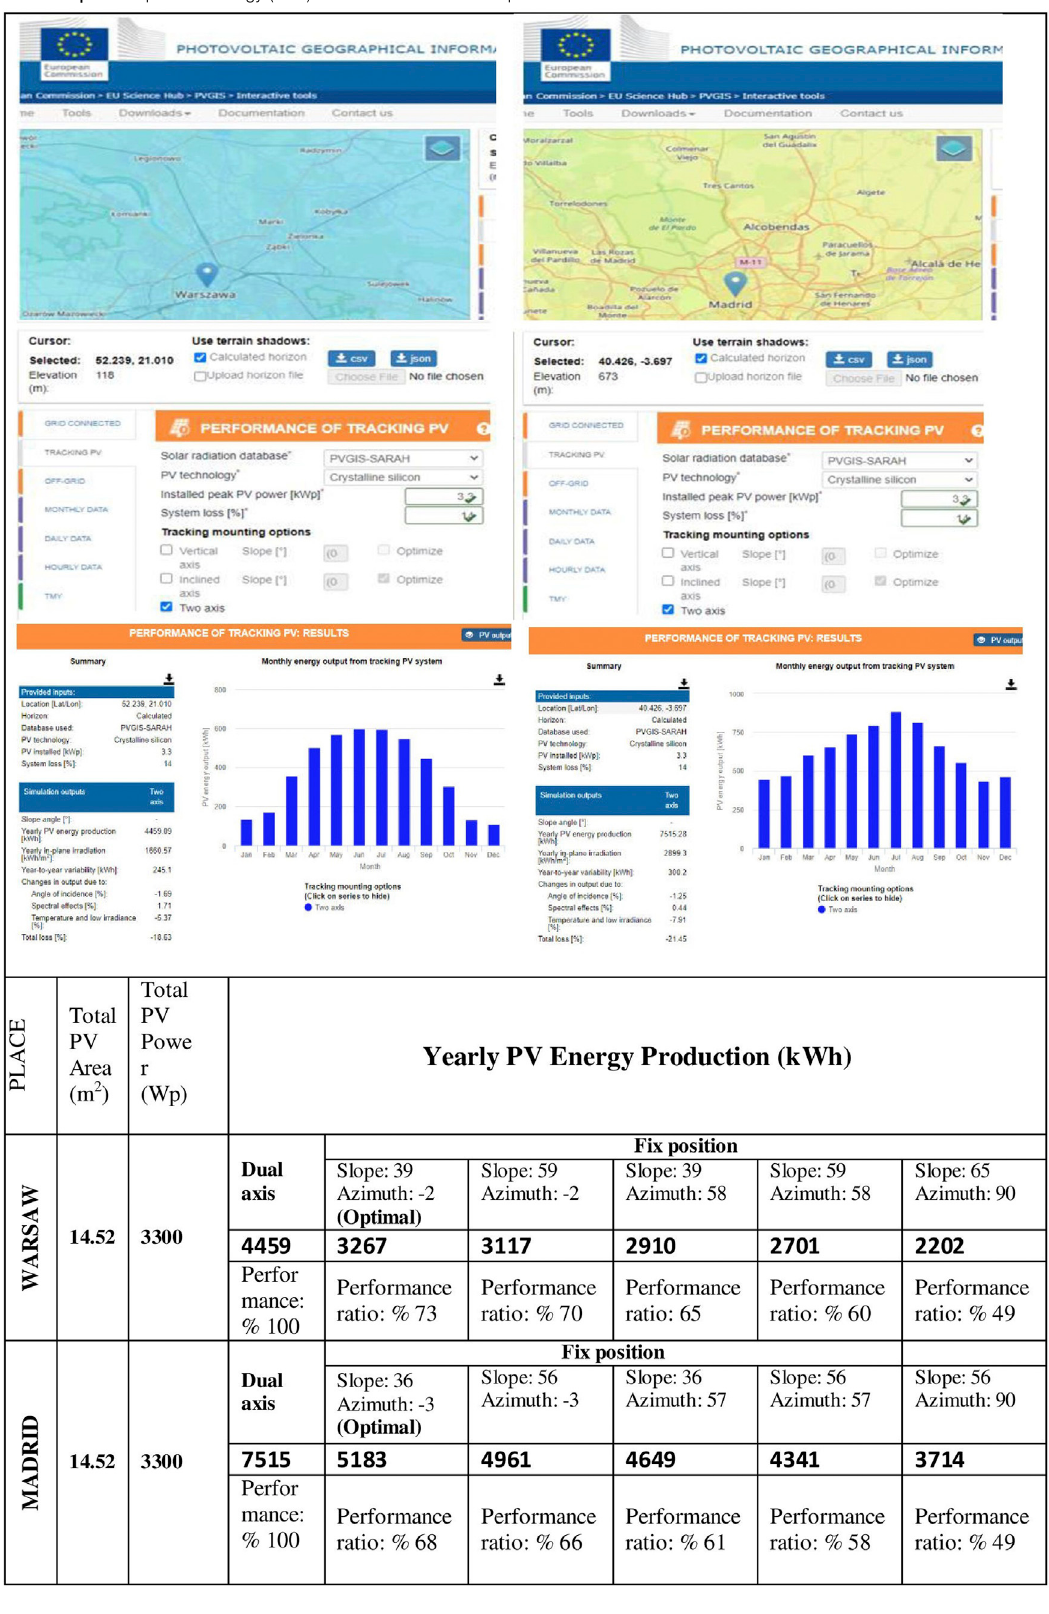
Frontiers in Energy Research |